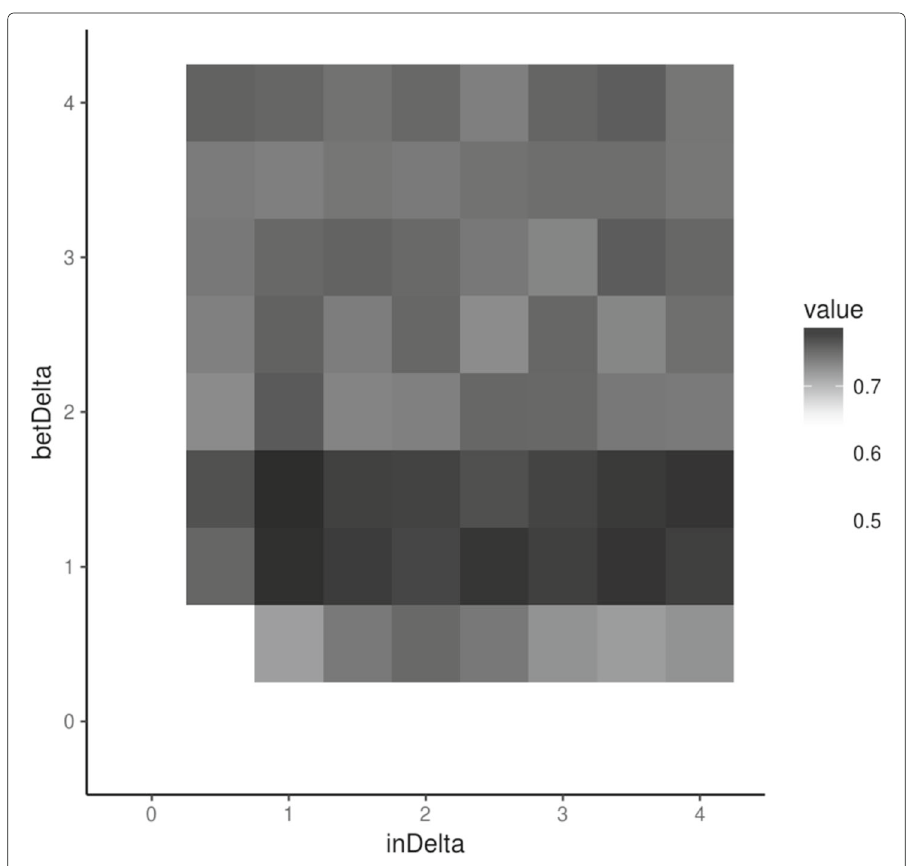
Fig. 5 The AUC values of the proposed model with different δ bet and δ in value on Celegans